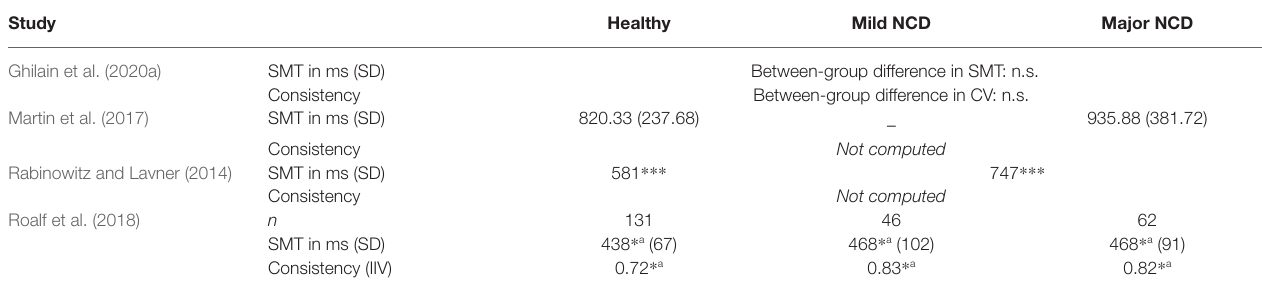
TABLE 3 | Studies investigating spontaneous motor tempo and spontaneous tapping in people with and without neurocognitive disorders. Study